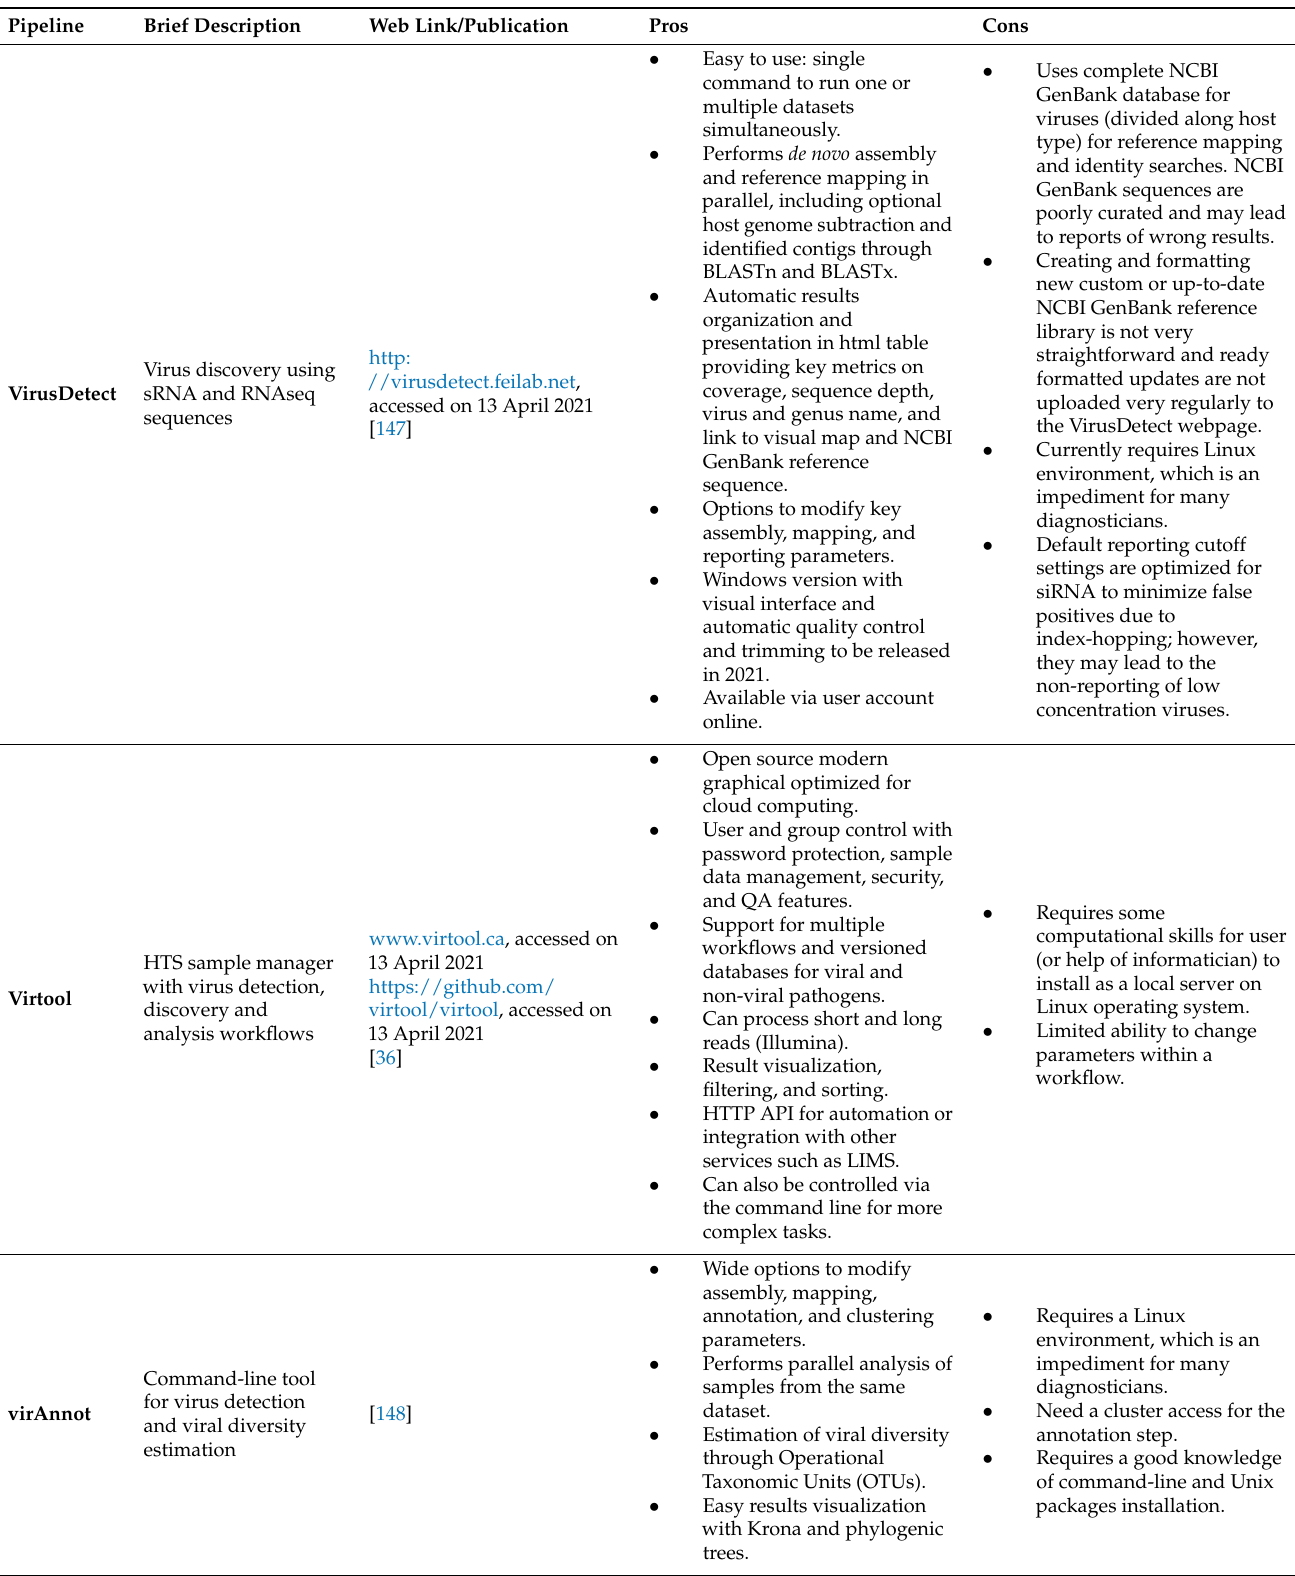
Table A1. List of selected easy-to-use analysis solutions for detection of plant viruses with their pros and cons.